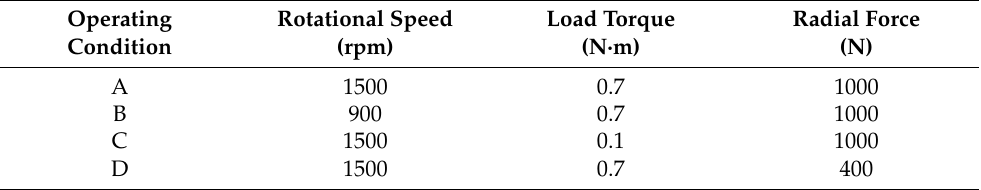
Table 2. Operating Conditions corresponding to the Paderborn